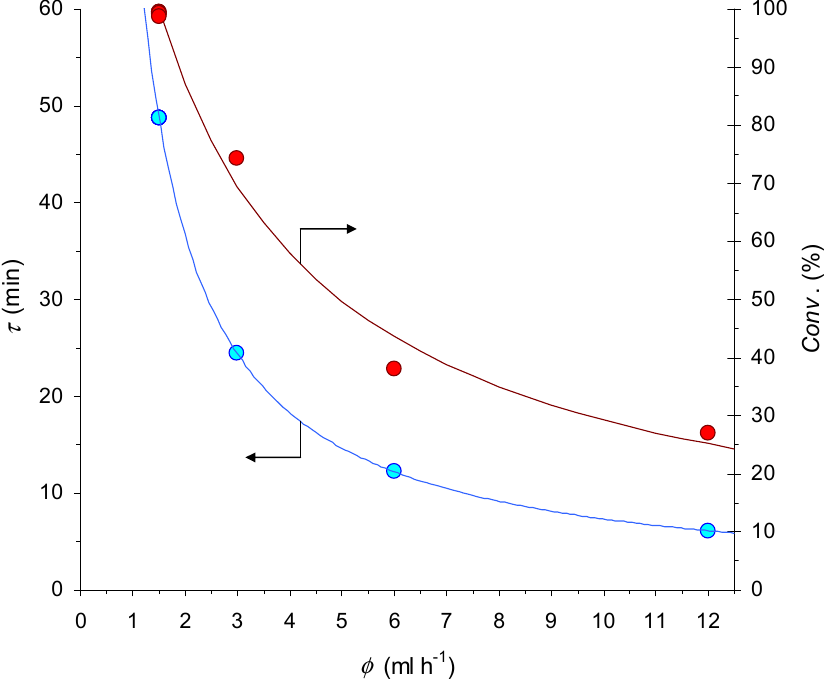
Figure 3. Graphical representation of the relationship between the flow-rate ( ф ), estimated residence time ( τ ), and conversion degree ( Conv. %) for the benchmark CuAAC reaction in the 10 cm-long MCFR (for the conditions see Table 2, entries 3–7).